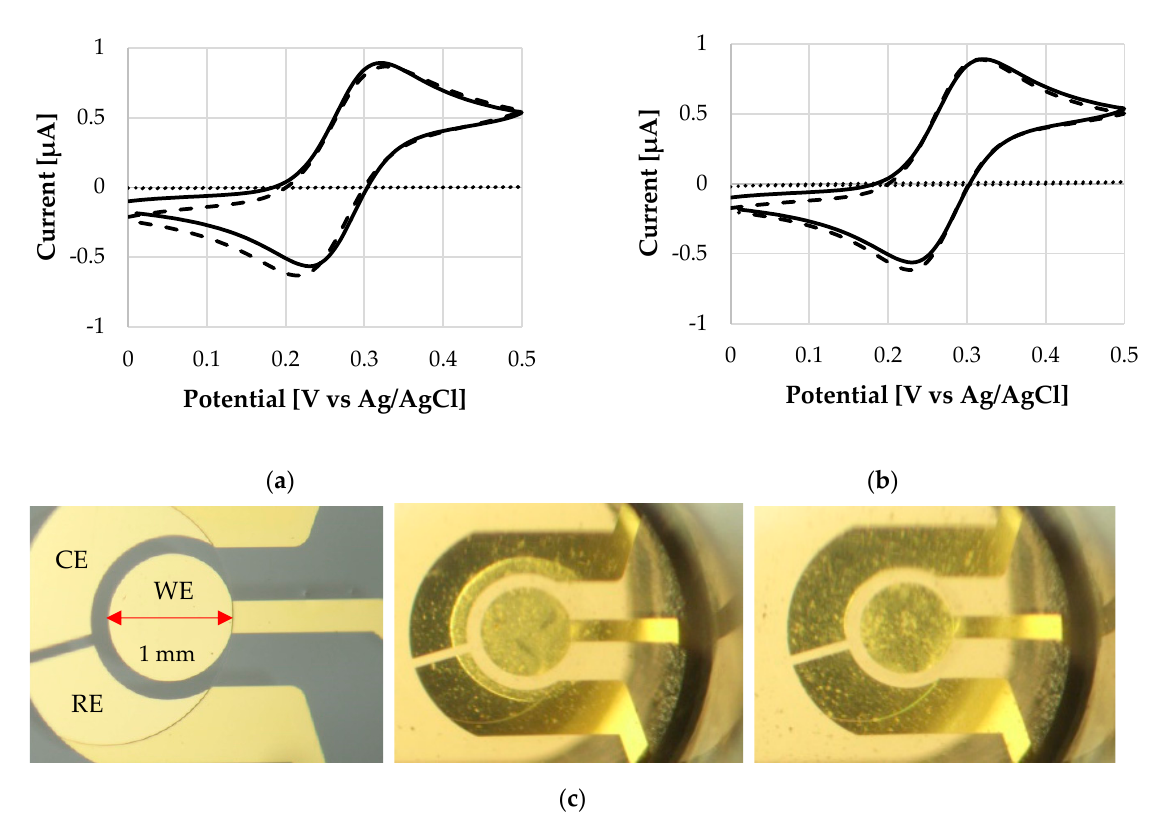
Figure 4. Cyclic voltammograms of the bare WE (plane line), and WE after the application of a polymeric coating (dotted line) and after polymer dissolution (dashed line) at 25 °C, of ( a ) L 30 D-55 polymer and ( b ) FS 30 D polymer. ( c ) From left to right: Micrograph of WE surface without any coating, WE with a coating on top at the beginning of its dissolution, WE after dissolution of the coating. Notice that the bulk solution becomes cloudy, see dissolution process in Video